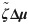
Final droplet velocity plotted against the effective activity ζ˜Δμ for different values of B.Inset: Droplet swimming steady state, coloured interface shows concentration (black to yellow: low to high) and vector field shows flow field scaled for visibility. Simulation parameters as listed in Tables 1 and 2 with D = 0.1 and γ = 1.